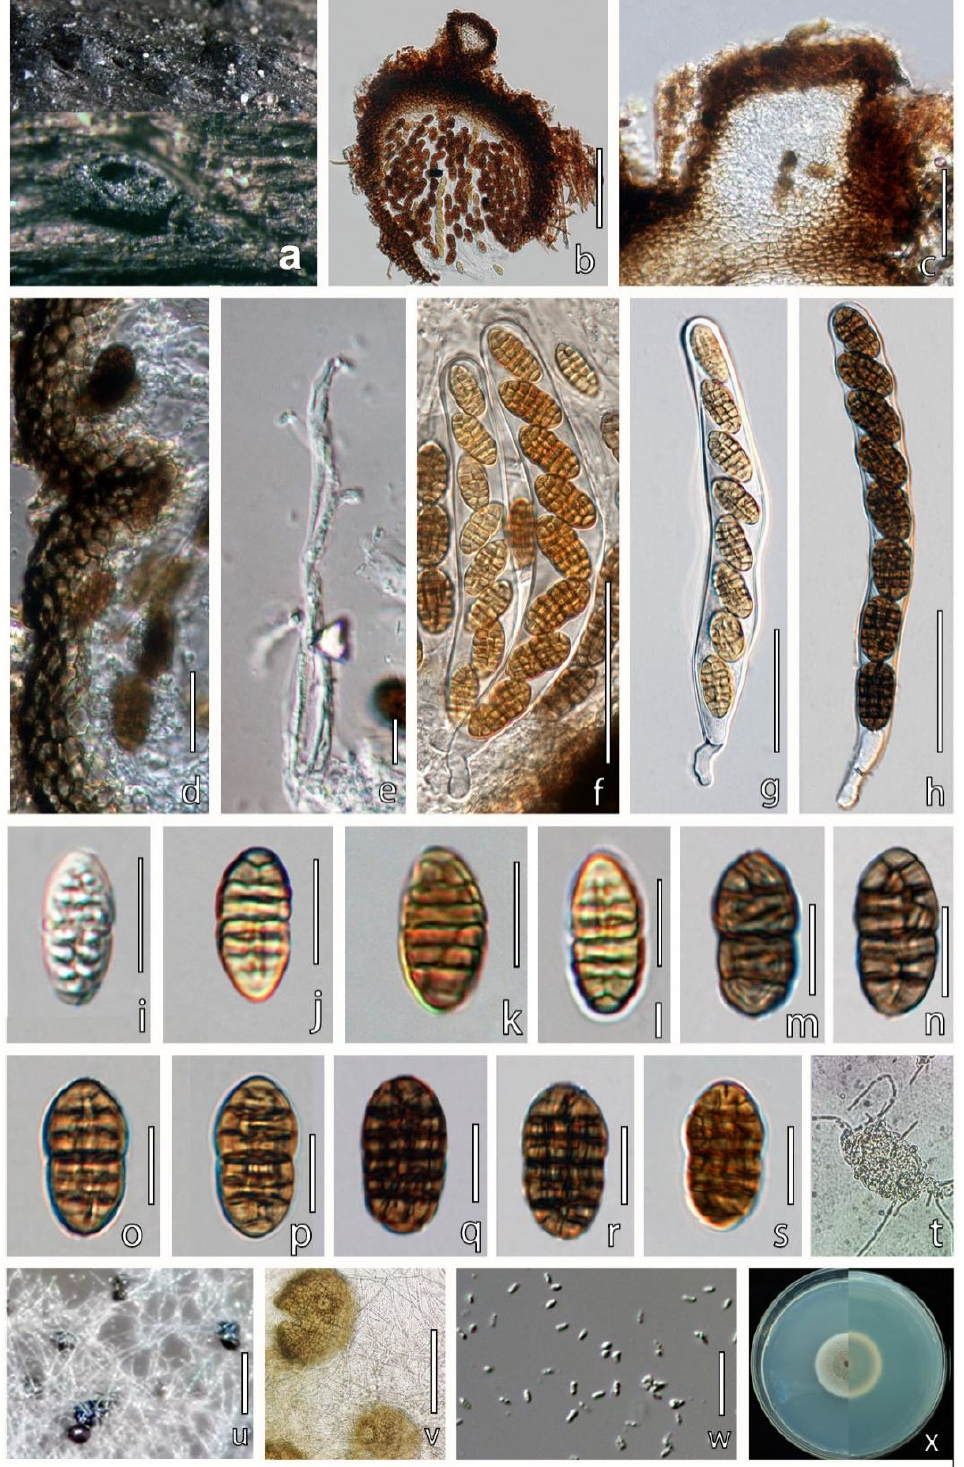
Figure 7. Parafenestella ulmicola (HMJAU 60180, holotype). ( a ) Ascomata on host surface. ( b ) Vertical section through ascoma. ( c ) Ostiole. ( d ) Partial peridium wall. ( e ) Pseudoparaphyses. ( f – h ) Asci. ( i – s ) Developmental stages of ascospores. ( t ) Germinating ascospore. ( u ) Pycnidia produced in four weeks old cultures on PDA. ( v ) Conidiomata. ( w ) Conidia. ( x ) Four weeks old culture on PDA. Scale bars: ( b ) = 100 μ m; ( c ) = 50 μ m; ( d , e ) = 20 μ m; ( f – h ) = 50 μ m; ( i – s ) = 10 μ m; ( u ) = 200 μ m; ( v ) = 100 μ m; ( w ) = 5 μ m.